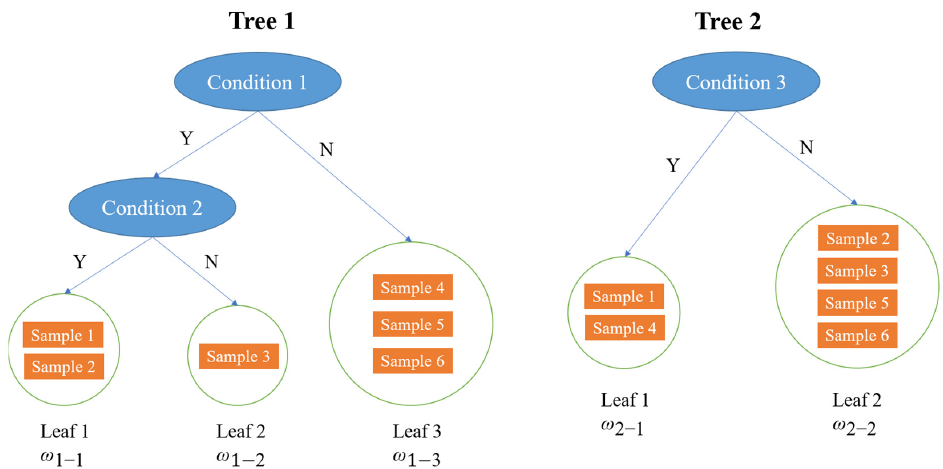
Figure 4. An example of CARTs.